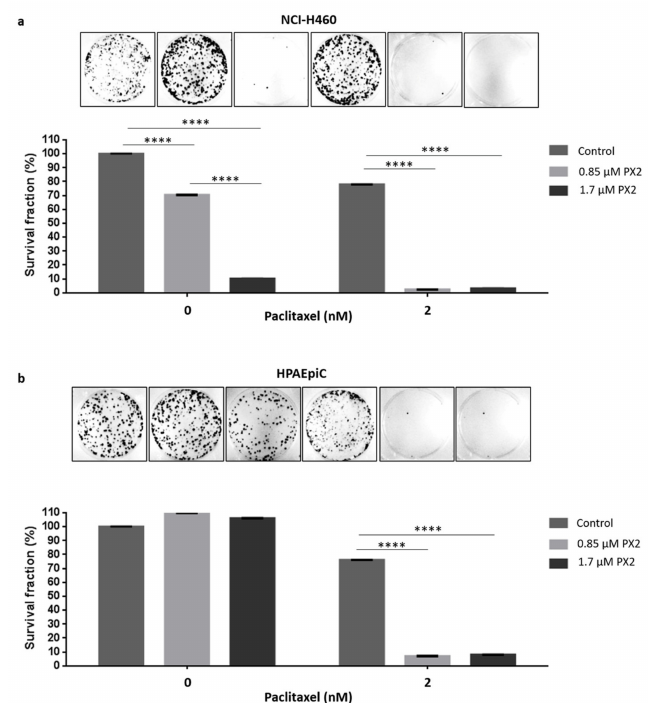
Figure 8. Pyranoxanthone 2 (PX2) treatment enhances paclitaxel-mediated cytotoxicity. NCIH460 ( a ) HPAEpiC ( b ) cells were treated with 0.85 µ M and 1.7 µ M of PX2 and / or paclitaxel (PTX) at 2 nM, for 48